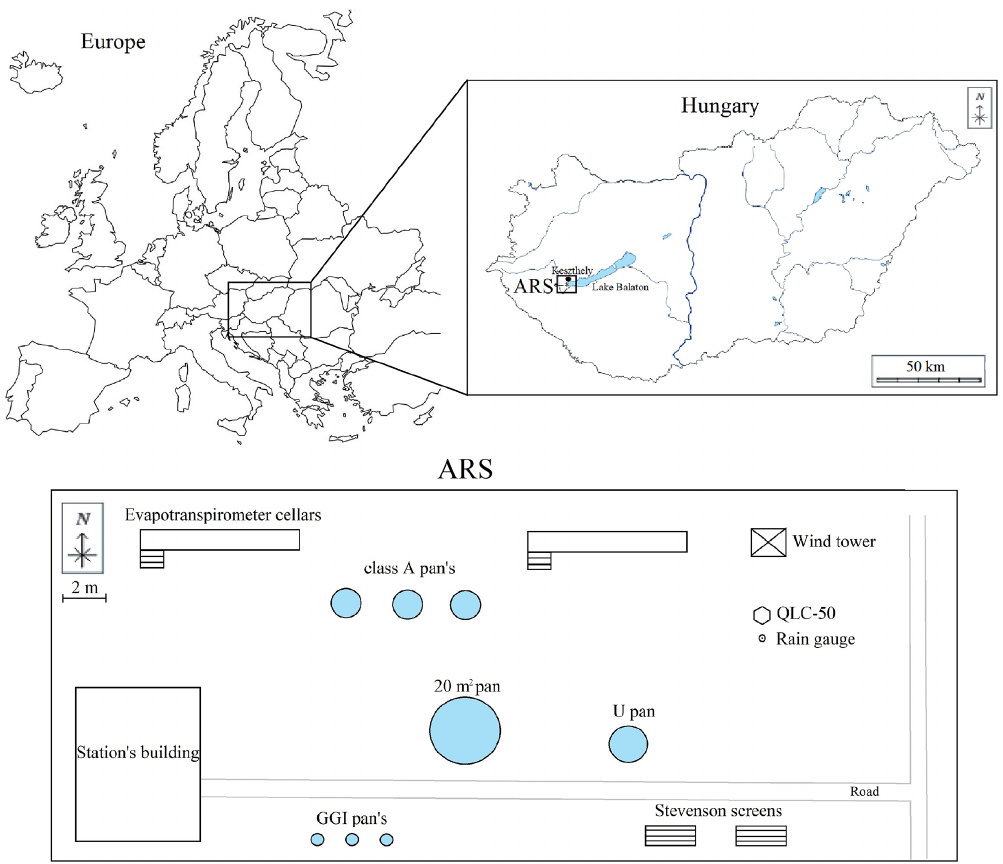
Figure 1. Location map of the study area with agrometeorological research station (ARS) at Keszthely, Hungary (from https://www. vectorstock.com, last access: 3 November